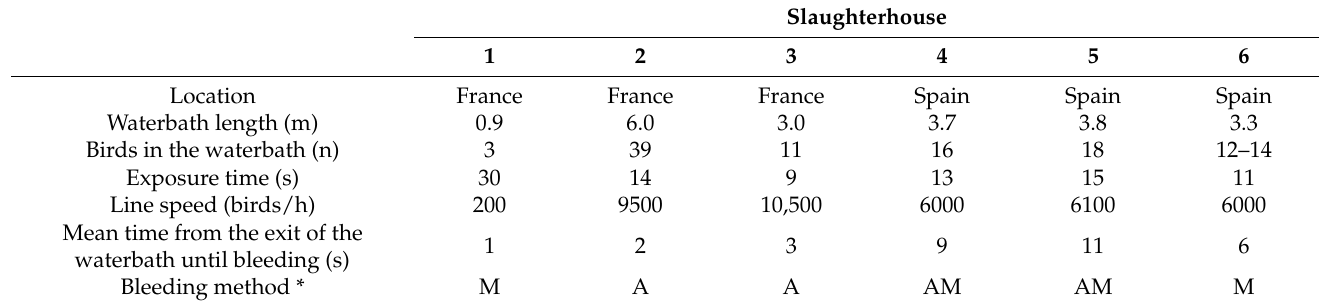
Table 1. Main characteristics of the six slaughterhouses (1 to 6) included in the study.